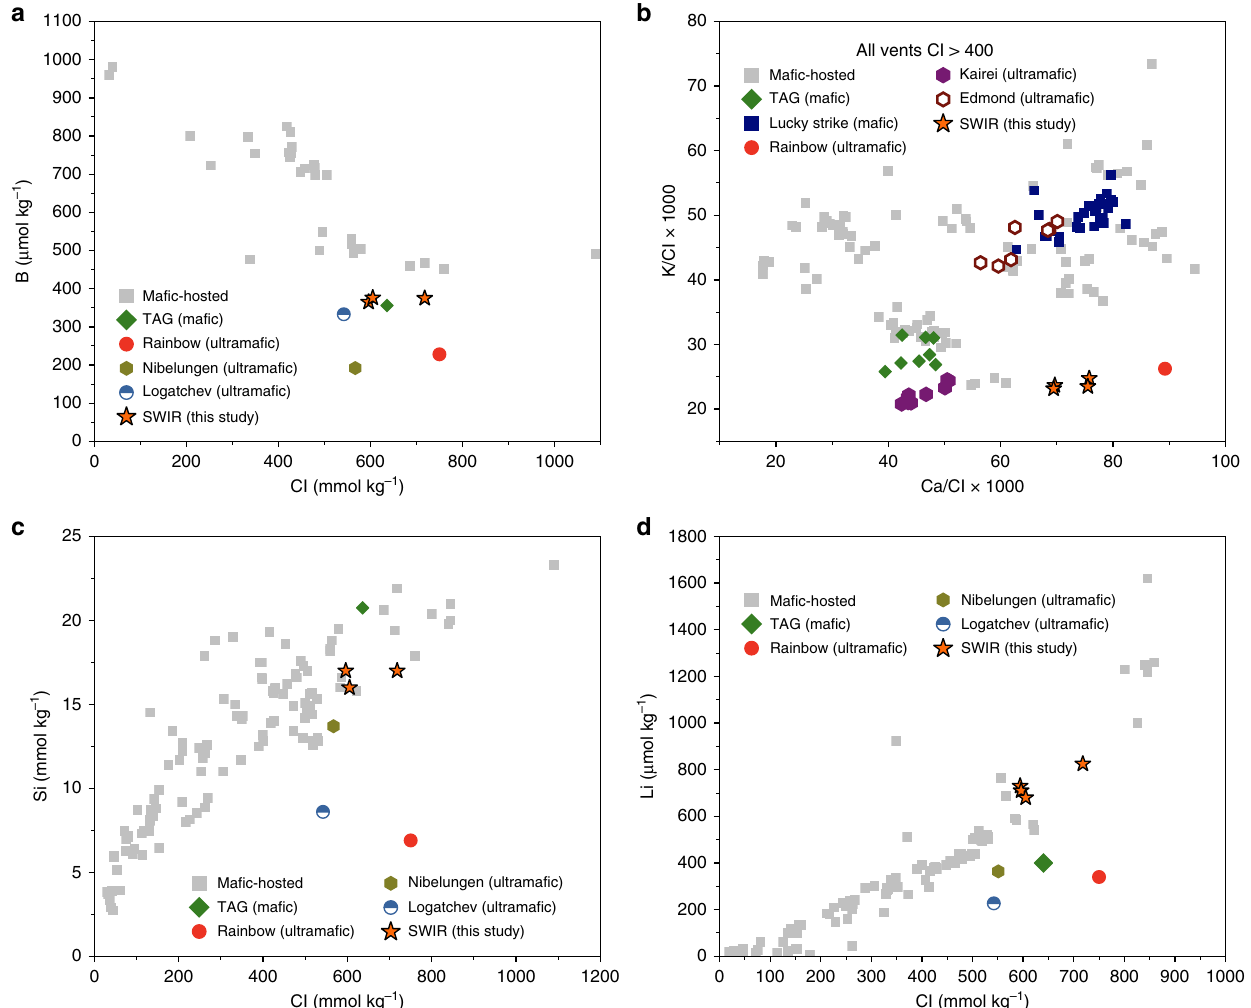
Fig. 2 Longqi-1 hydrothermal vent fl uids in comparison with vent fl uid compositions from other vent sites. a Dissolved B versus chloride; b dissolved K/Cl versus Ca/Cl; c dissolved silicon versus chloride; d dissolved lithium versus chloride (see text). Data sources for ma fi c-hosted systems are as follows: EPR 57 – 61 ; JdFR: ASHES 62 ; Southern JdFR 63 ; MEF 28,64 ; MAR: TAG 43,65,66 ; and Lucky Strike 30 . Other host lithologies on MAR: Rainbow 67 ; Nibelungen (8 ˚ 18 ′ S) 29 ; Logatchev (14 ˚ 45 ′ N) 38 ; and Central Indian Ridge 68 are displayed for comparison. All the error bars are smaller than the scale of the